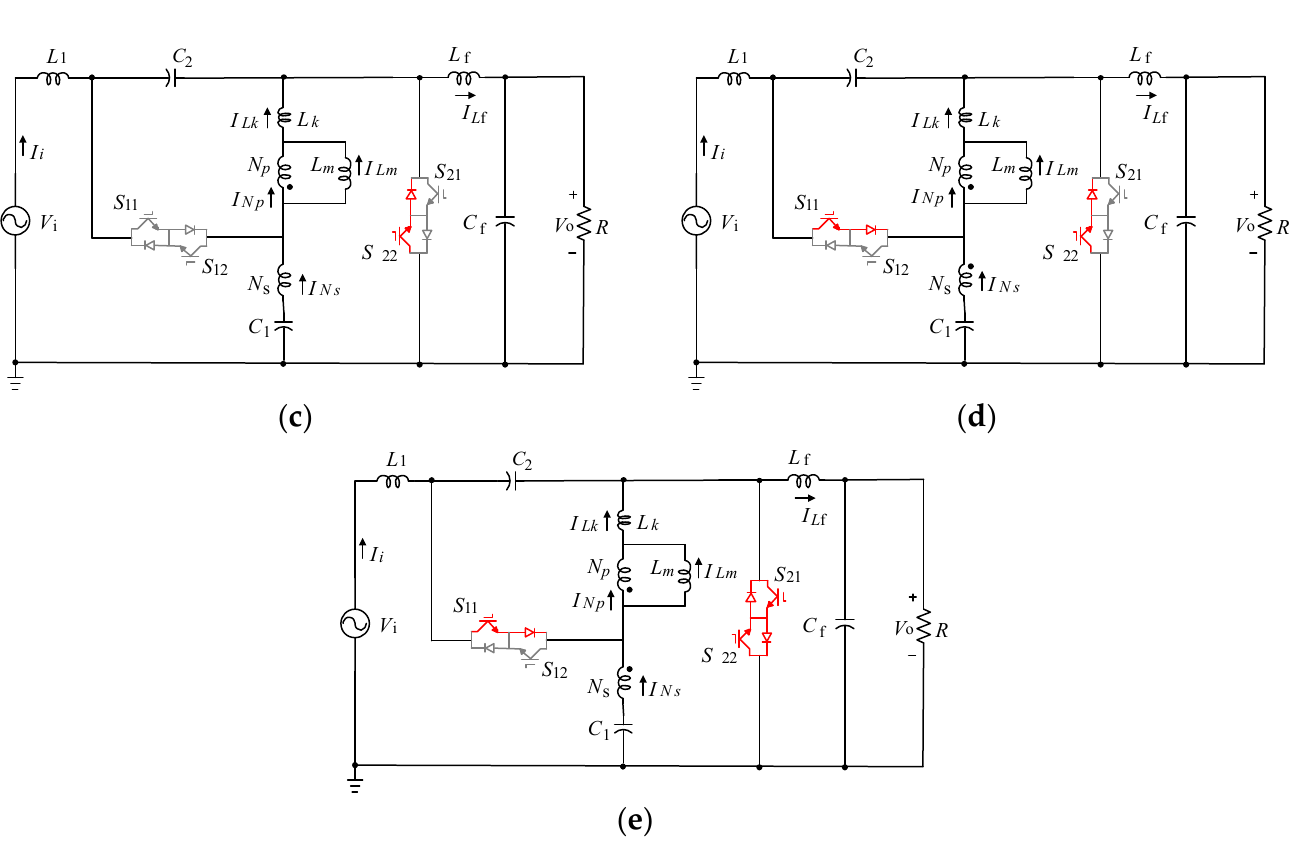
Figure 5. Operation intervals of the introduced topology for boost in-phase state when V i > 0, ( a ): non-shoot-through state, ( b ): commutation state if I i + I Lk − I lf > 0, ( c ): commutation mode when I i + I lk − I lf < 0 and I Lk = I Lm , ( d ): commutation state if I i + I lk - I lf < 0 and I Lk − I Lm < 0, ( e ): shoot-through state.